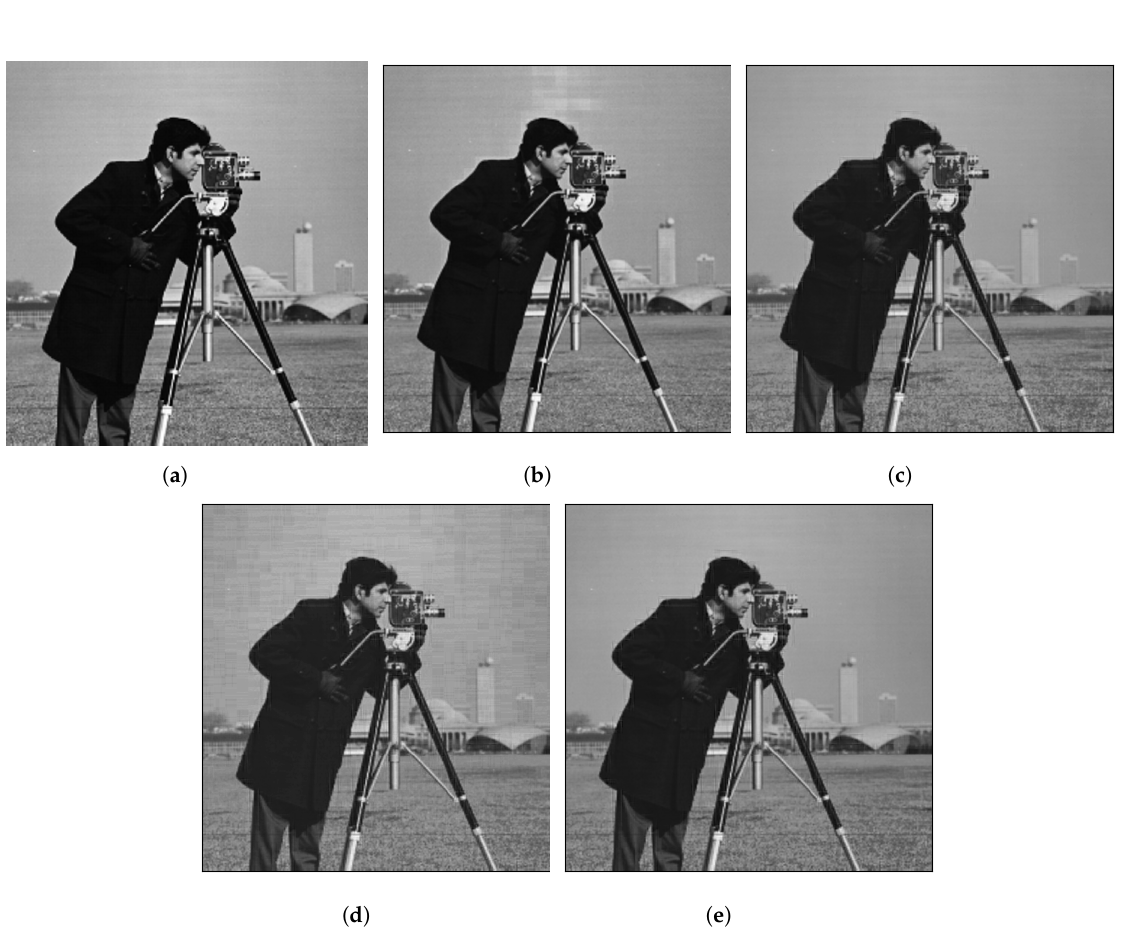
Figure 8. DCT and iDCT PSNR comparison. ( a ) Original. ( b ) Mitchell, PSNR = 29.91. ( c ) MBM, PSNR = 17.70. ( d ) Mitch-w8, PSNR = 26.64. ( e ) Pwl-Mit, PSNR =